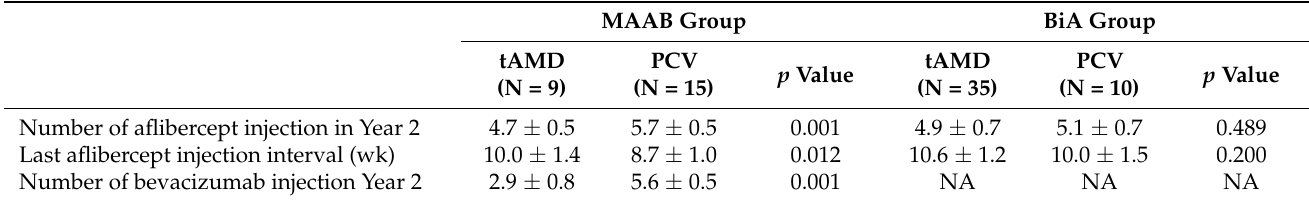
Table 3. Number and interval of injections in the second